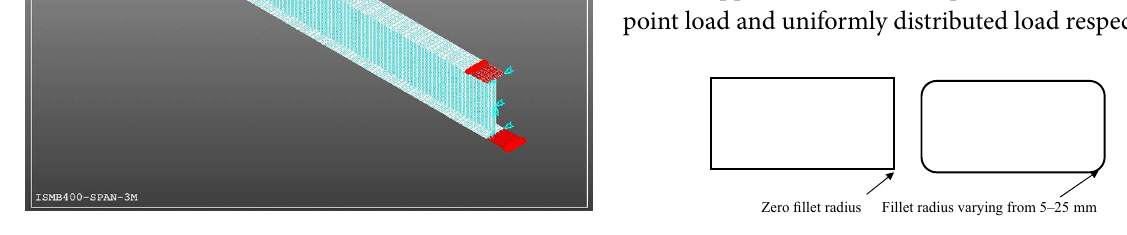
Fig. 9. Simulations of end moments Fig. 10. Fillet radius Table 3. Comparison between finite element and analytical buckling moment for plain-webbed beam Sr.